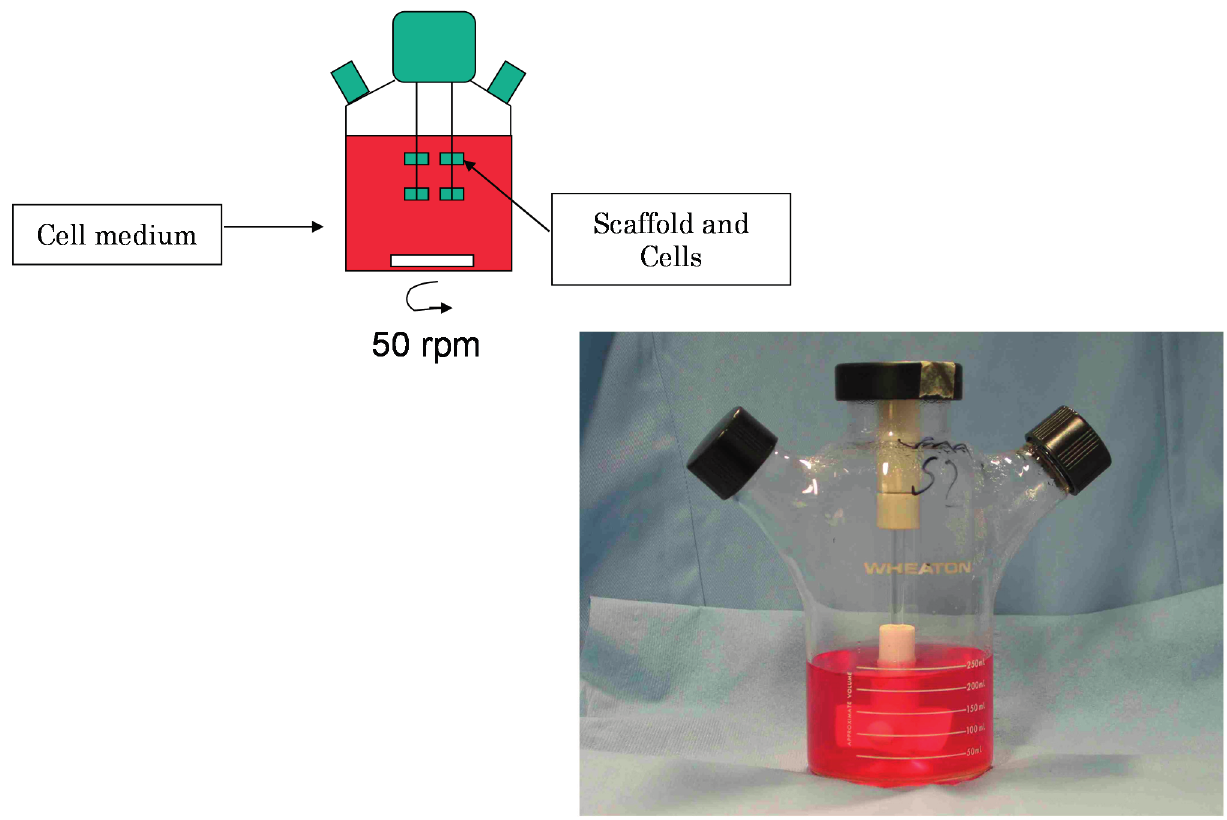
Figure 4. Schematic illustration of spinner